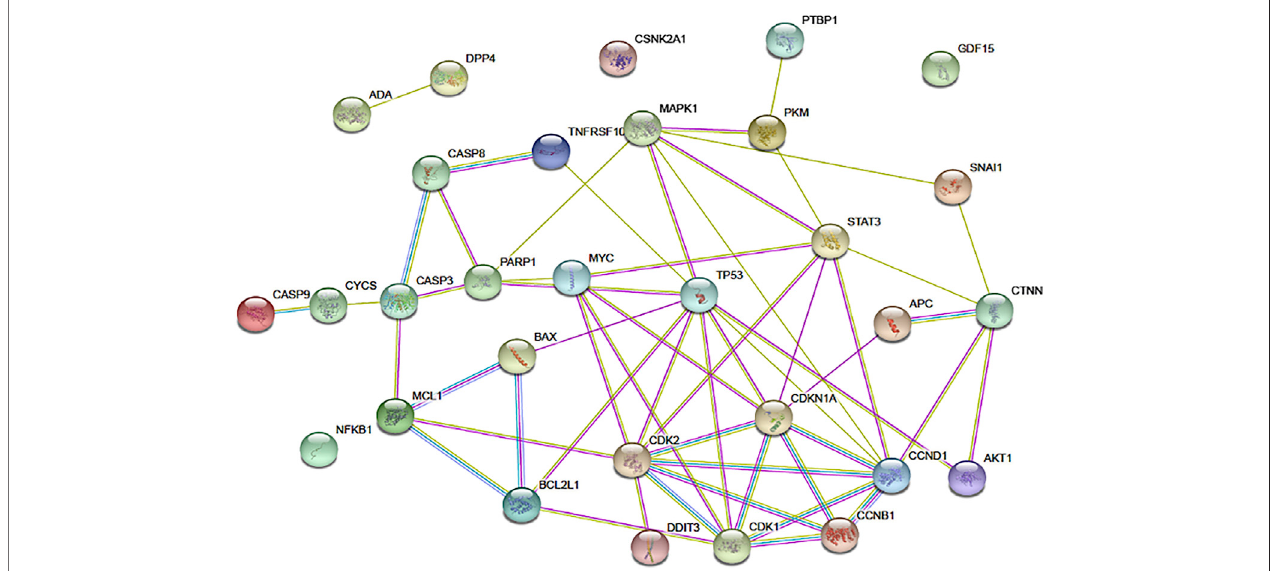
FIGURE 3 | The network of connections between regulatory pathways and molecules that are known to be impacted by apigenin. The functional protein association tool STRING was used to map the inter-connectedness of impacted proteins, identi fi ed through physical protein interactions in Homo sapiens , as shown. Connections between nodes are color coded depending on the interaction type: blue, curated databases; fuchsia, experimentally determined; green, textmining; light purple,protein homology. ConnectionswithinthisnetworkforDPP4,ADA, CSNK2A1,and CDF15 arenotshown,butpublisheddataonnon-physicalinteractions (e.g., gene co-expression) indicate that such links